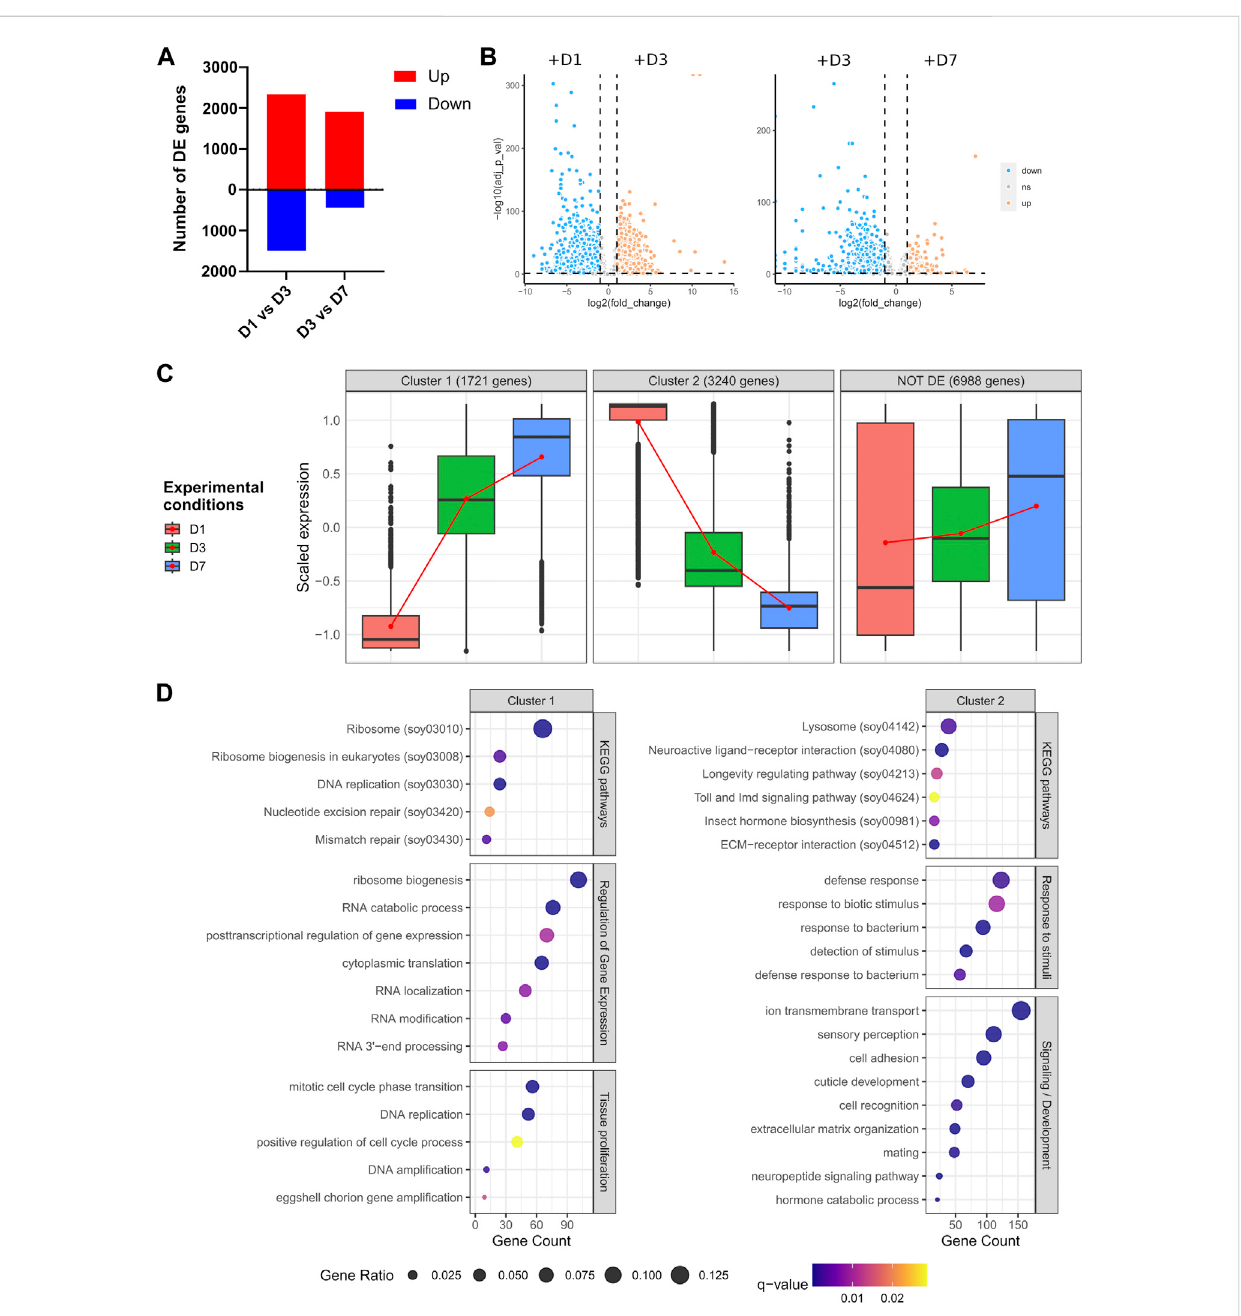
FIGURE 3 Differentialexpressionanalysisacrossgermariumdevelopment. (A) Numberofgenesup-ordownregulatedbetweenD1andD3,andD3andD7. (B) Volcano plots depicting the overall differences in gene expression between the conditions tested. (C) Clustering of gene expression throughout ovarian development. Two clusters are depicted, with gene expression progressively increasing between early and late females (cluster 1), or genes downregulated from D1 to D7. (D) GO and KEGG pathway enrichment analysis of genes belonging to clusters 1 and 2. Genes non-differentially expressed can be found in Supplementary Figure